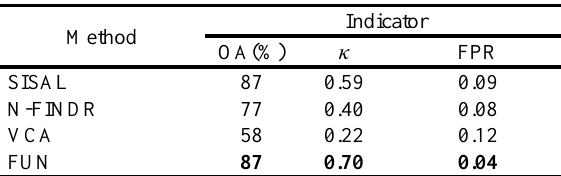
Table 2. Numerical evaluation of different hyperspectral CD methods in the USA data